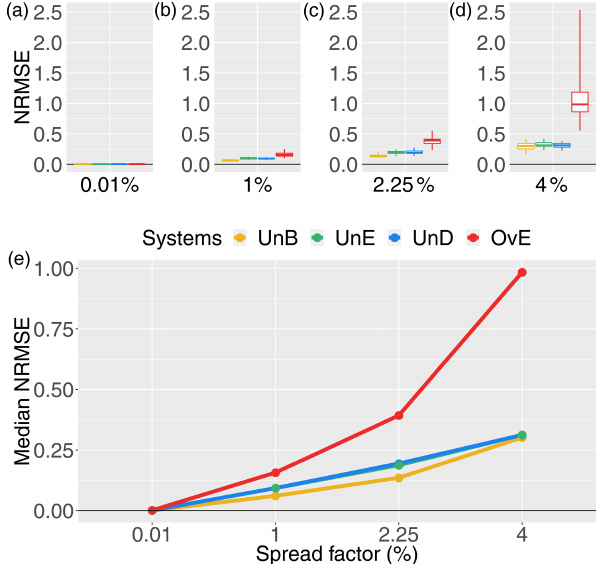
Figure 7. NCRPS score for 1d ahead synthetically generated fore- casts of different quality: unbiased system (UnB, yellow), underdis- persed system (UnD, green), underestimating system (UnE, blue) and overestimating system (OvE, red). Systems are based on en- sembles generated with four different spread factors (0.01%, 1%, 2.25% and 4%). (a–d) Boxplots represent the maximum value, per- centiles 75, 50 and 25, and minimum value over the 10 studied catchments. (e) Median score